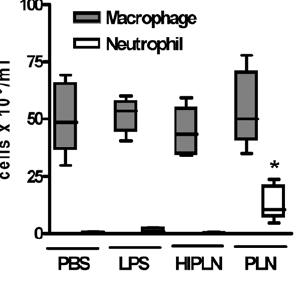
Figure 3. Cell composition in BALF of PBS-, LPS-, PLN- and heat inactivated PLN-treated mice. Macrophage and neutrophil counts in BALF from WT mice, 6 hours after inoculation of PBS, LPS (2 pg/ mouse), heat inactivated PLN (HIPLN 500 ng/mouse) or PLN (500 ng/ mouse). Data are plotted in Box&Whiskers graph (median + interquartile range N=5 per group). * P , 0.05 versus